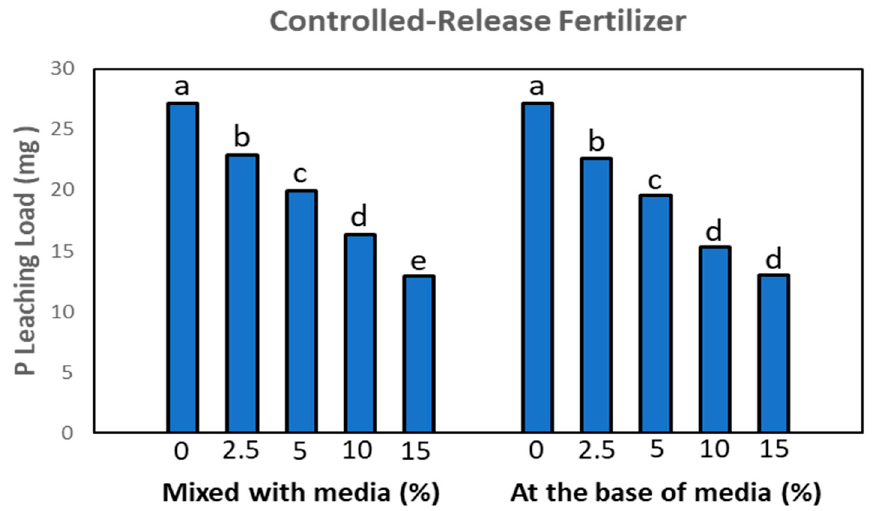
Figure 5. Mean dissolved reactive phosphorus (DRP) loading loss in leachate as affected by FGD gypsum mixed with media or placed at the bottom of containers fertilized with a con-trolled-release fertilizer. Within each gypsum application method, bars with the same letter are not significantly different ( p < 0.05).